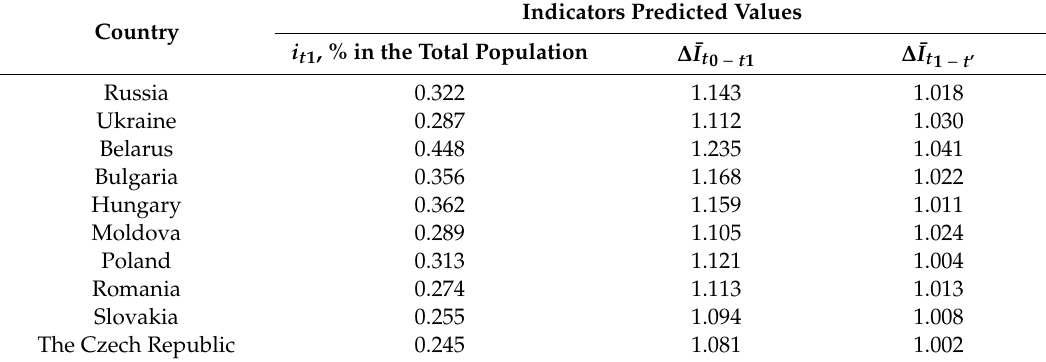
Table 2. Predicted numbers of infected people at the time t 1 and COVID-19 spread rate in the Eastern European